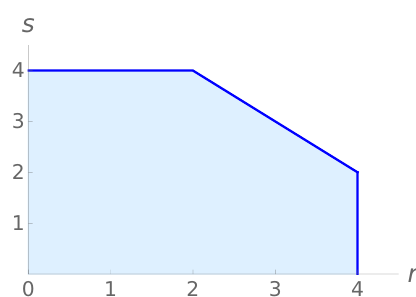
Figure 3 . Example of the interdependence of the tensorial ranks. The coloured area shows the ranks ( r, s ) in ( q 1 , q 2 ) that result from the q 3 = − ( q 1 + q 2 ) replacement applied to a polynomial with ranks r 1 , r 2 , r 3 ≤ 2 in q 1 , q 2 , q 3 . In this case the maximum rank in q 2 obeys R 2 ( r ) ≤ min(4 , 6 − r ) . Note that the excluded region with r, s ≤ 4 and s + r > 6 corresponds to the highest-rank configurations, which involve a large number of tensor